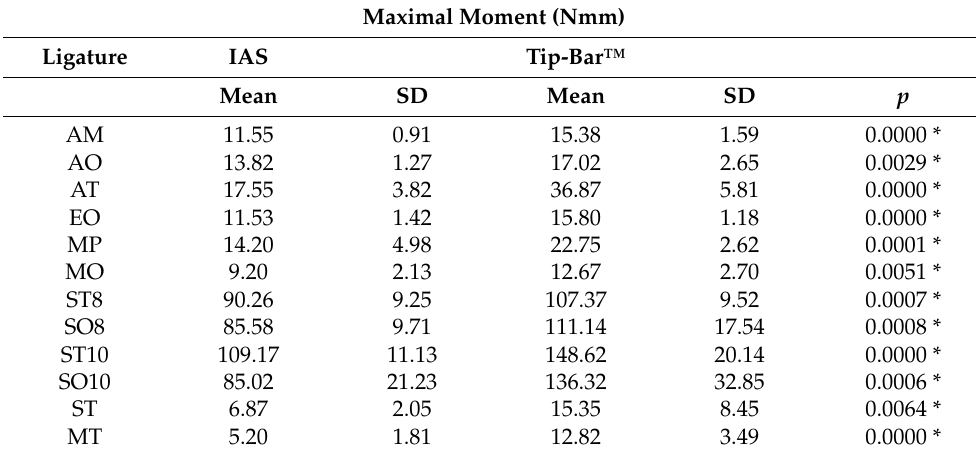
Table 3. Overview of the maximal moment (mean and SD) of the various ligature types and bracket combinations. The p values (*) refer to a comparison between the IAS and Tip-Bar™